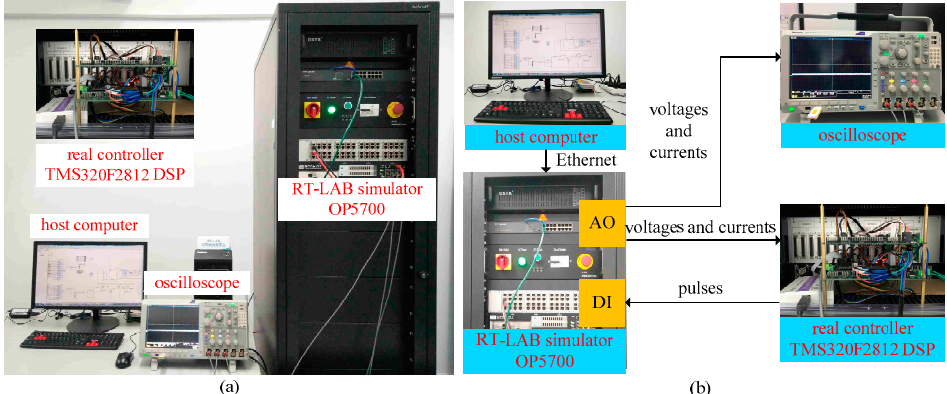
Figure 16. Experimental platform for paralleled multi-inverter system based on hardware-in-loop simulation. ( a ) Whole; ( b ) Structure.